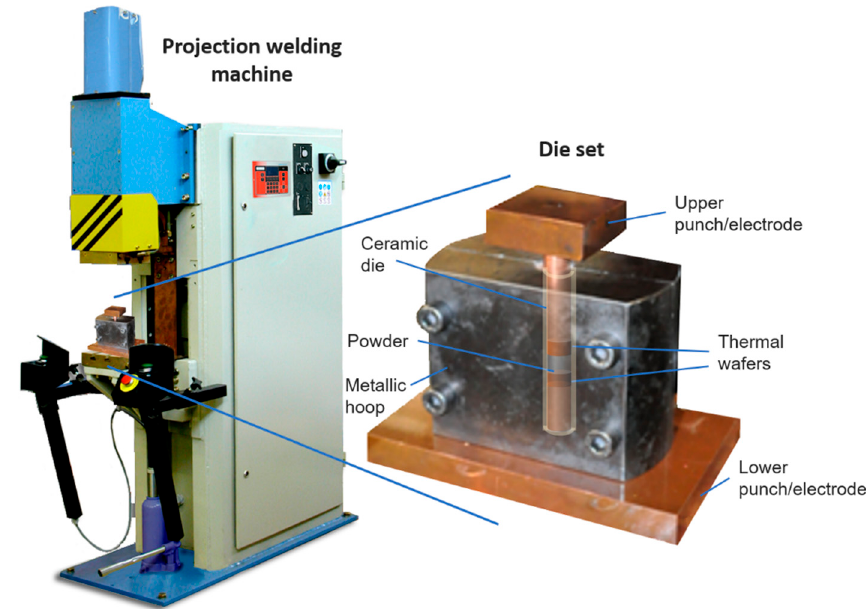
Figure 1. Electrical resistance welding machine adapted to act as the medium-frequency electrical resistance sintering (MF-ERS) equipment, and detail of the die set with a recreation of the interior.